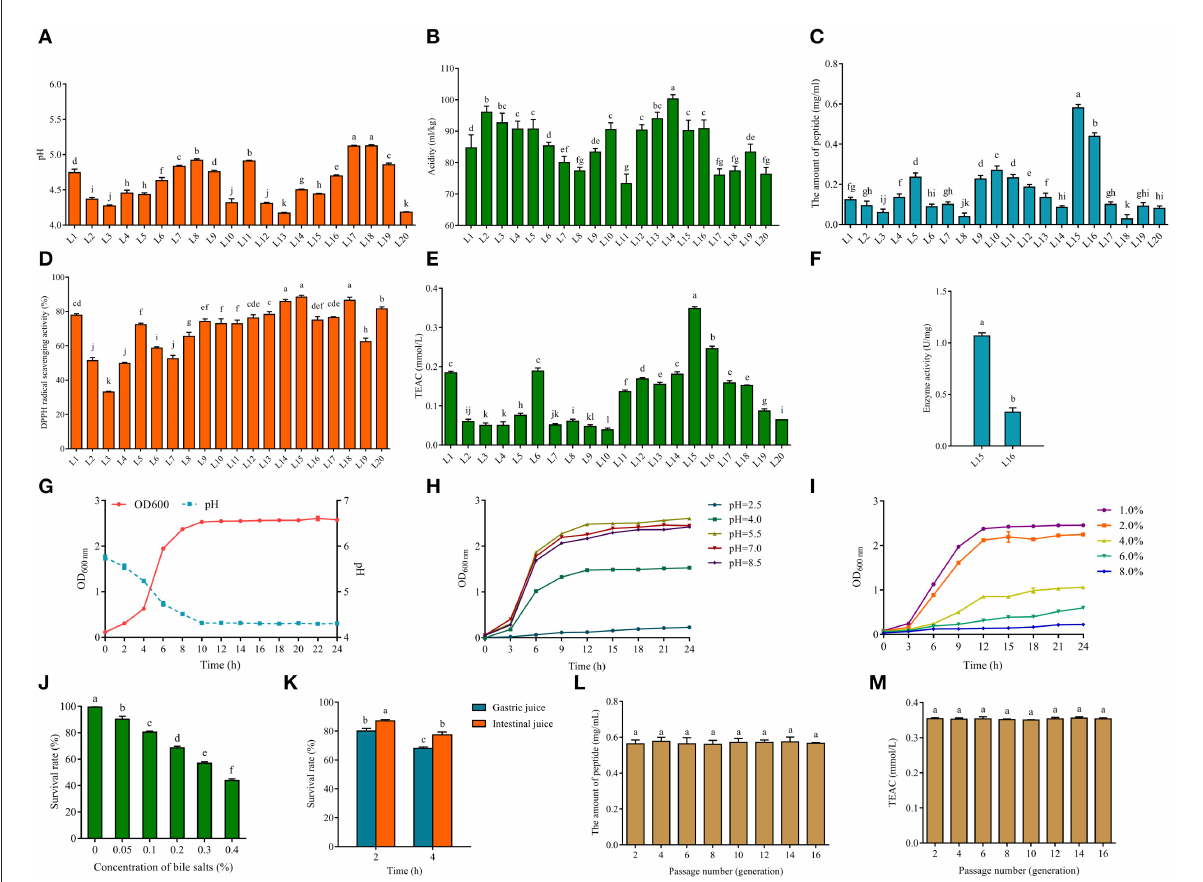
FIGURE1 pH (A) and acidity (B) of fermented milk produced from screened LAB (L1-20). The amount of peptide (C) of fermented milk of 20 screened LAB (L1-20). The DPPH radical scavenging ability (D) and Trolox equivalent antioxidant capacity (TEAC) (E) of fermented milk of 20 screened LAB (L1-20). Enzyme activity (F) of fermented milk of L15 and L16. Growth curve and acid production capacity of L. fermentum L15 (G) . (H) Growth characteristics (optical density, OD 600nm ) of L. fermentum L15 grown in MRS medium at different pH values (F; 2.5, 4.0. 5.5, 7.0, and 8.5). (I) Growth characteristics (optical density, OD 600nm ) of L. fermentum L15 grown in MRS medium at different NaCl concentrations (w/v; 1, 2, 4, 6, and 8%). (J) The survival rate of L. fermentum L15 treated for different concentrations of bile salts. (K) The simulated gastrointestinal fluid environment in vitro on L. fermentum L15 growth. Genetic stability of peptide production (L) and TEAC (M) of fermented milk of L. fermentum L15. Different lowercase letters indicate significant differences between groups ( p < 0.05).